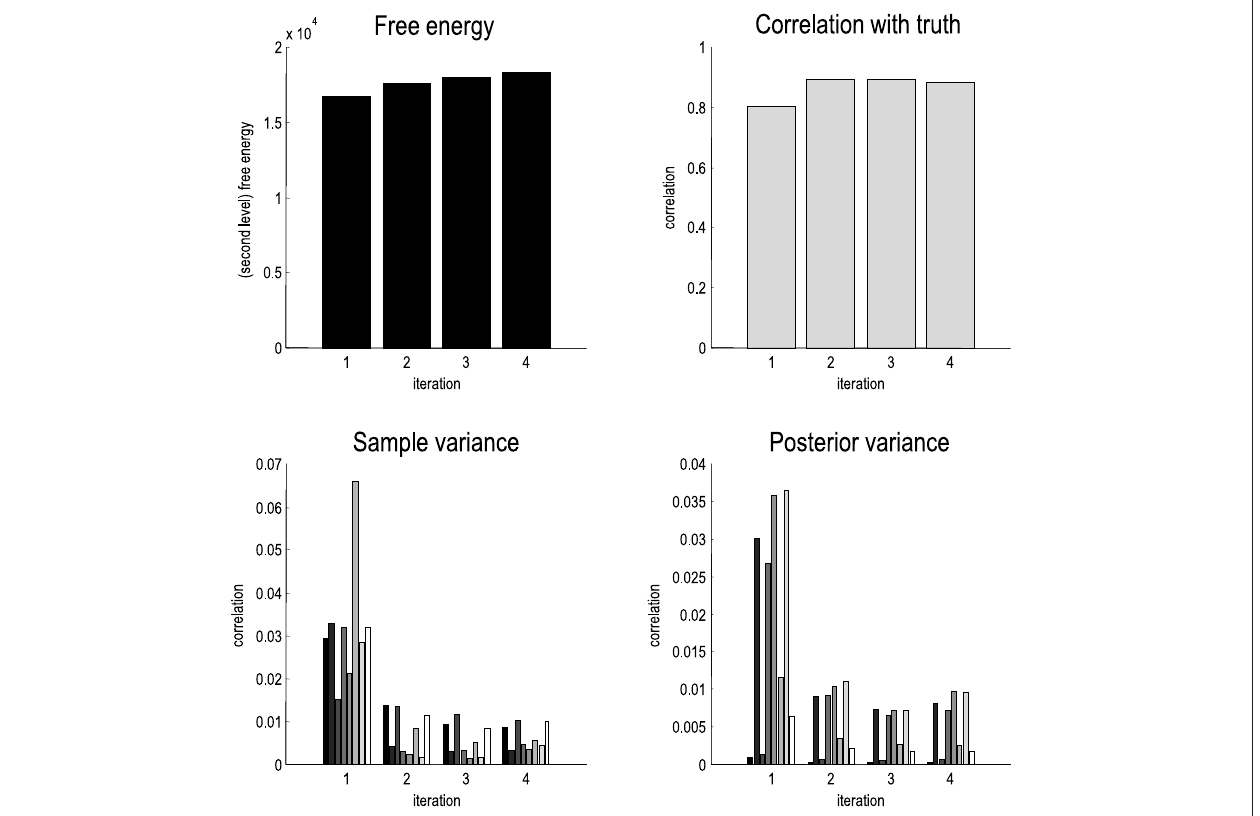
FIGURE 3 | Upper panels: The (second level or total) free energy (left) and correlations with true parameter values (right) over iterations of empirical Bayesian inversion of the simulated data. In the absence of local maxima and other convergence failures, this free energy would otherwise saturate after the first iteration. Lower panels : these report the sample and posterior variance of the interesting (condition specific) scaling effects, averaged over subjects. These variances fall markedly after the second iteration and then remain relatively stable.